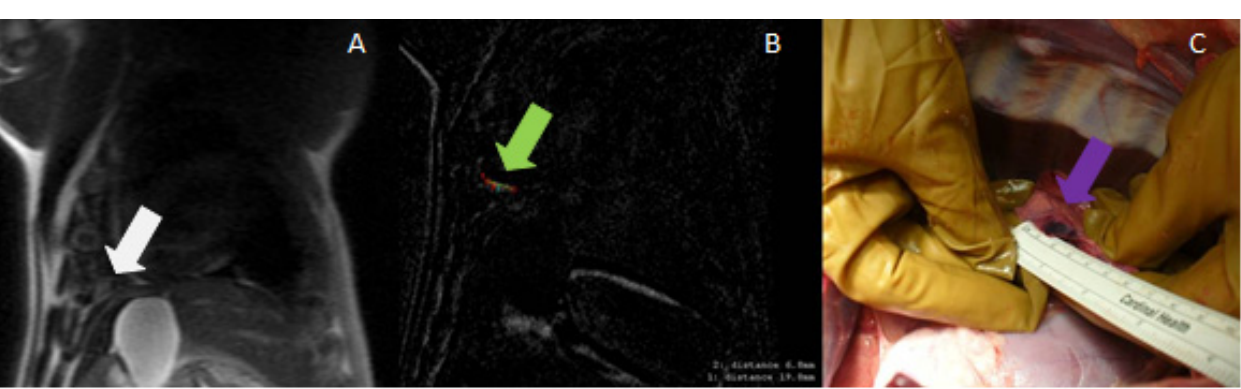
Figure 6. ( Left ) The blue circles in this coronal MRI above the diaphragm represent two focal spots planned, both localized inside the green square which represents the area available for treatment. The red crosses in the middle of the image mark the position of the diaphragm. ( Right ) Sagittal view of the image used for treatment planning. The rectangles represent the depth of the focal spots. The blue region corresponds to the beam path across the adjacent tissue.